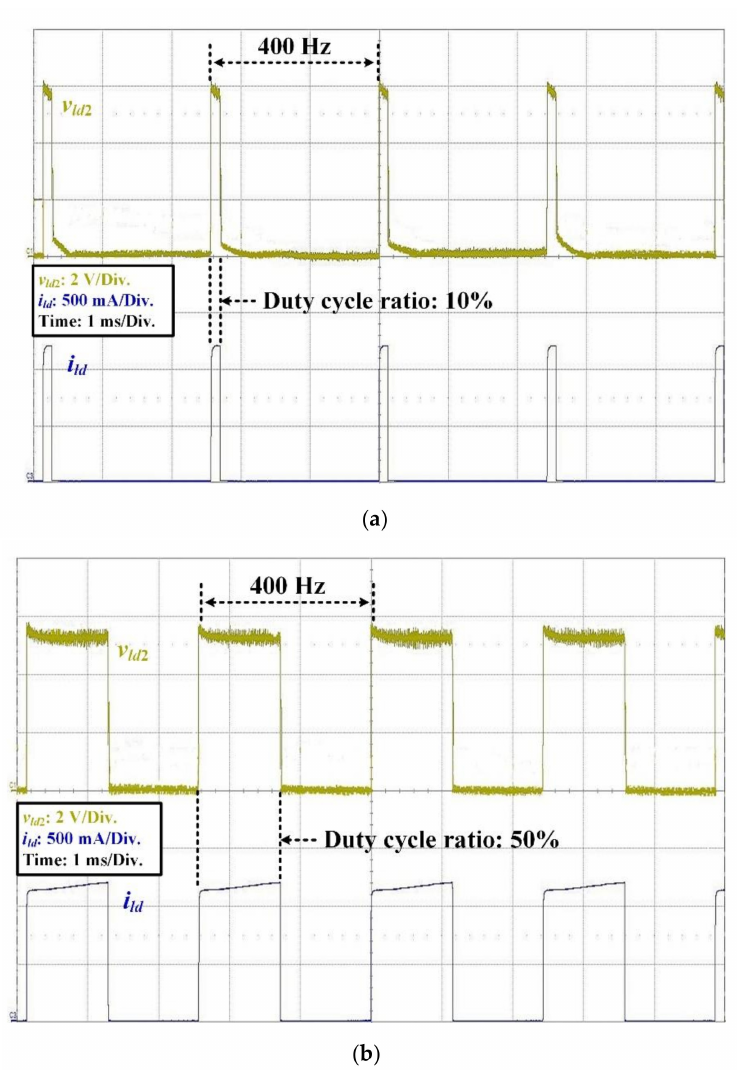
Figure 23. Waveforms of BBLD 2 driving voltage v ld 2 and current, D pdcm was set in ( a ) 10% and ( b )